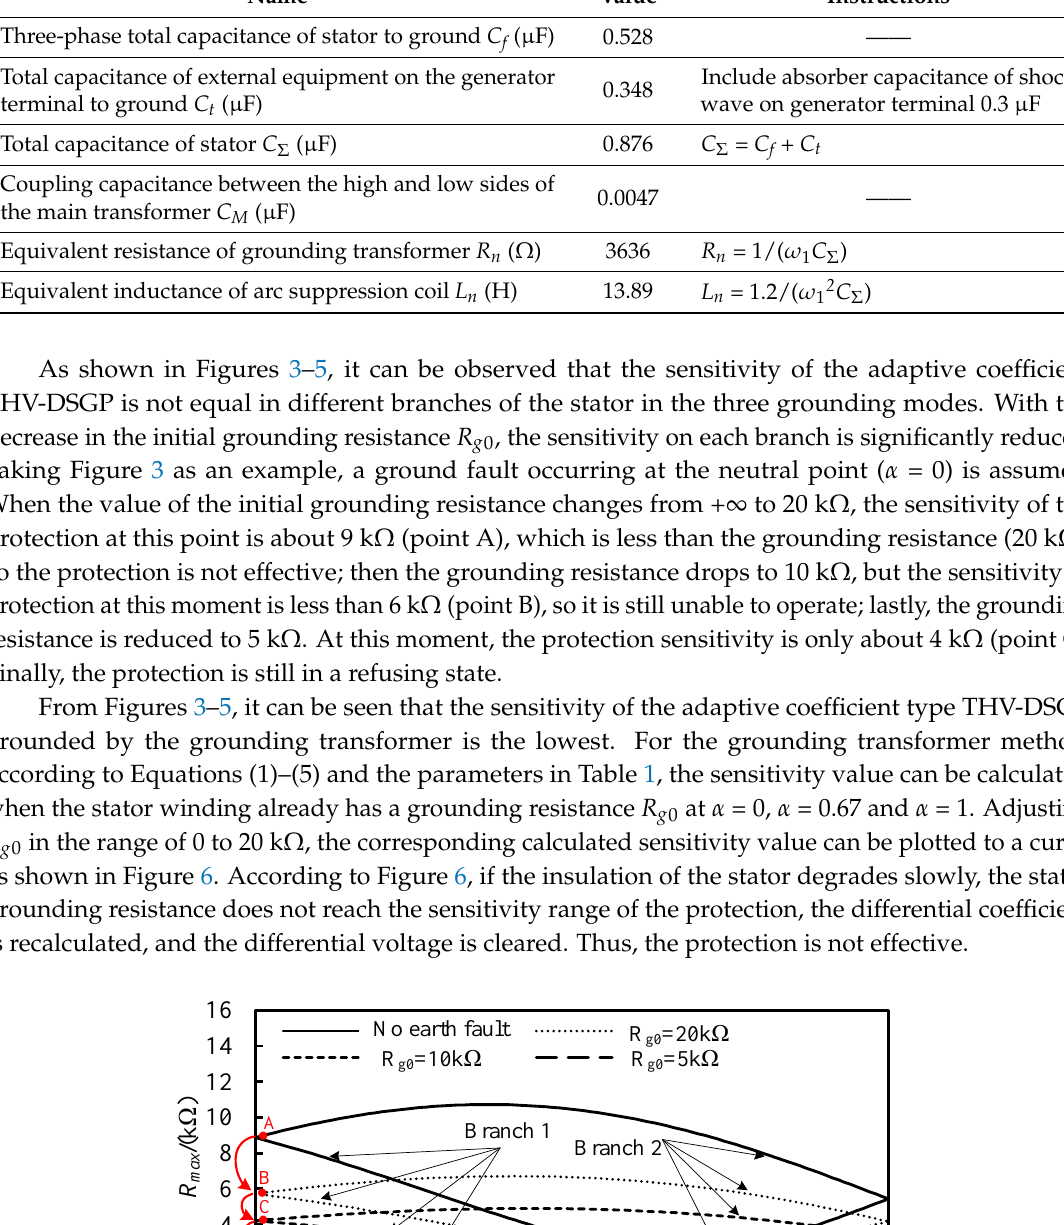
Table 1. Parameters of a 300 MW generator.